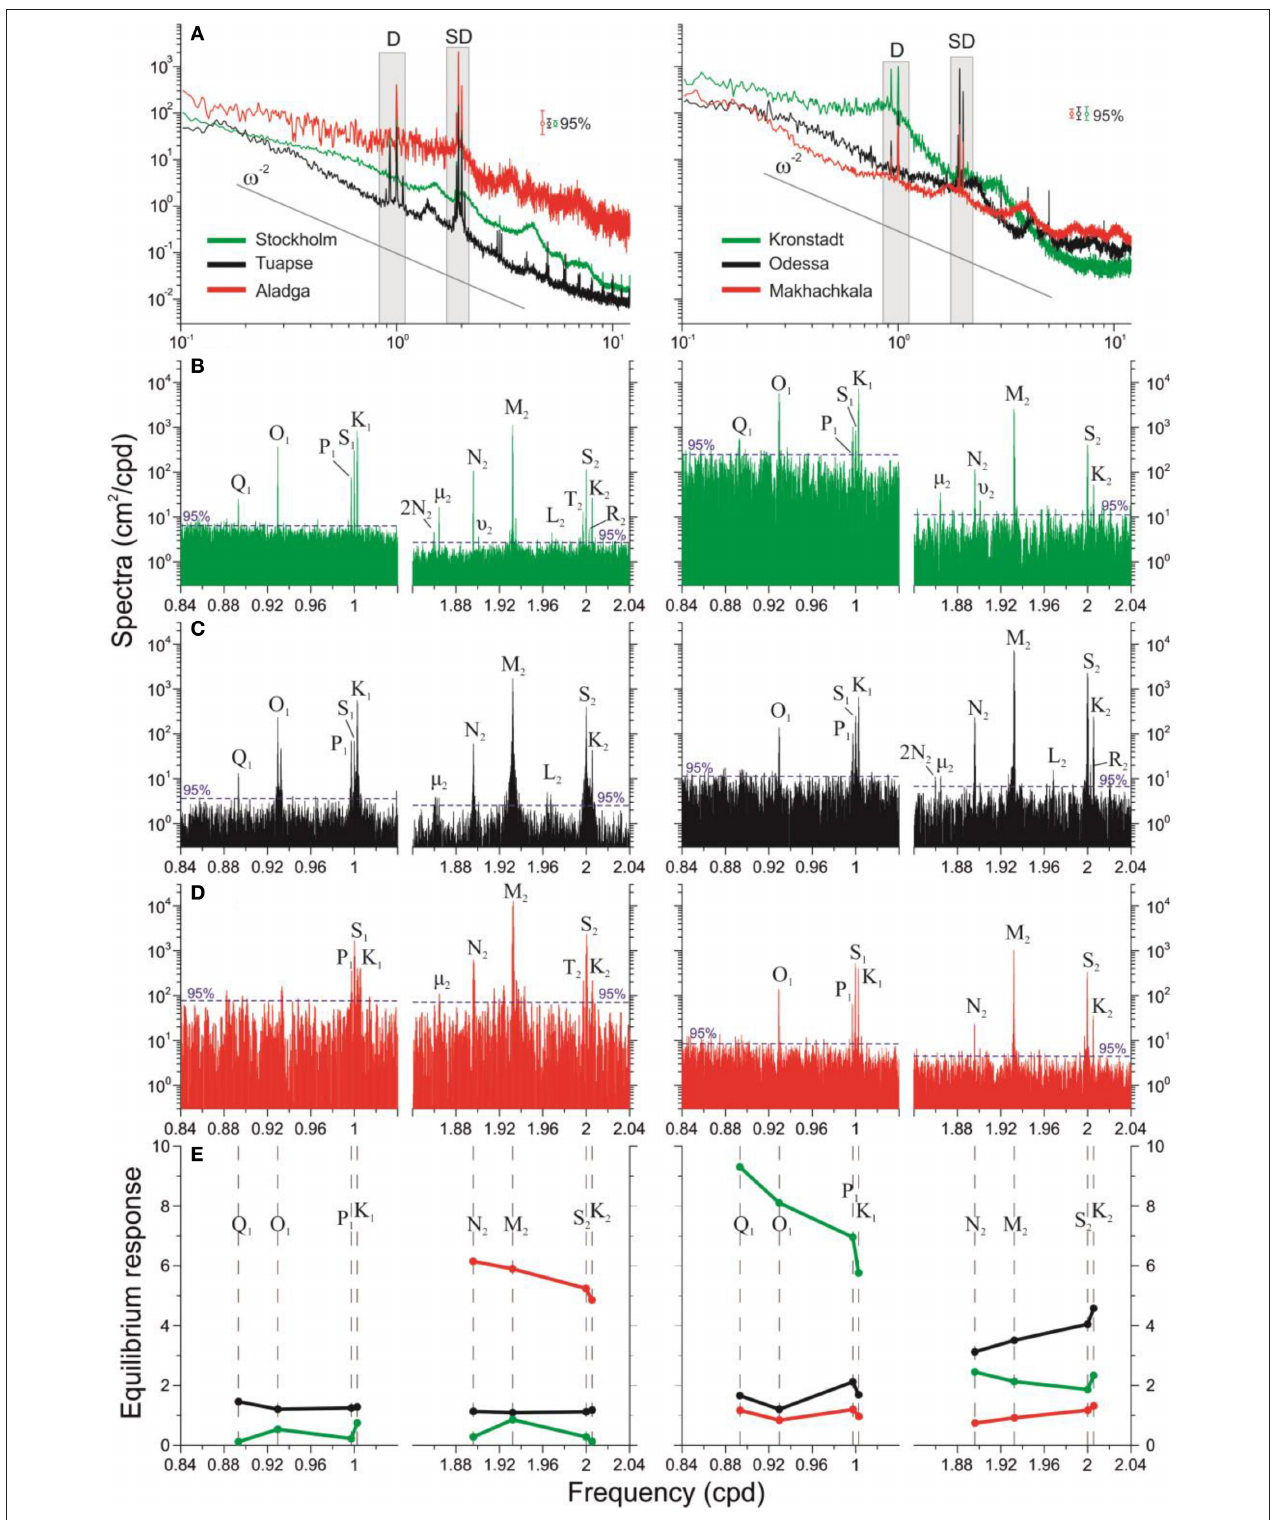
FIGURE 1 | Sea level spectra for six stations in the Baltic Sea (green), Black Sea (black), and Caspian Sea (red); the left column of plots is related to “deep-sea” stations, the right column to “shallow-water” stations. The stations are indicated in Figure 2 . (A) Low-resolution spectra at six stations; the